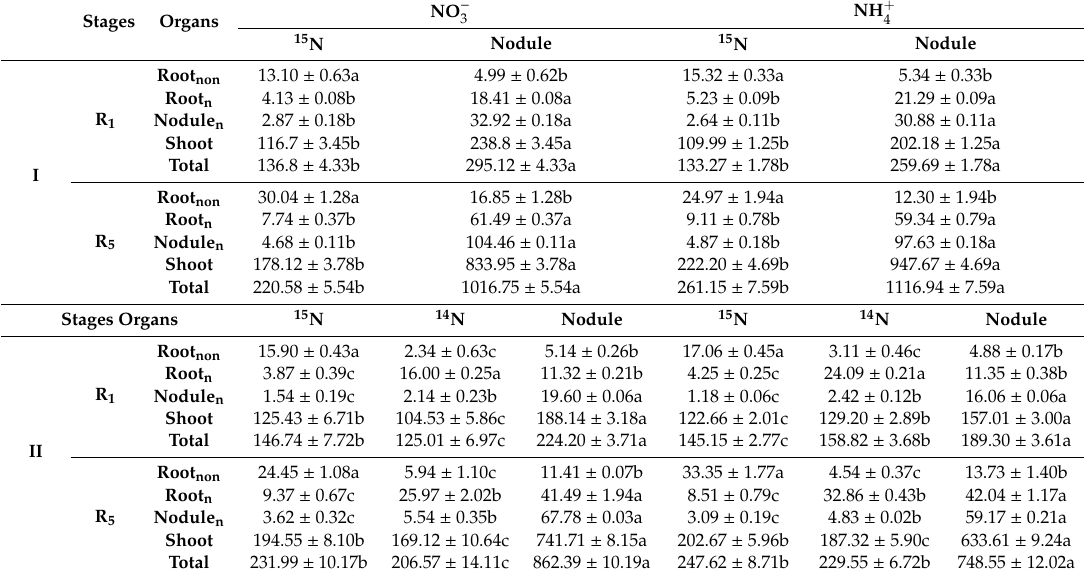
Table 6. The accumulation of N fixation from fertilizer and nodule-fixed N in each parts of the dual root soybean (mg /